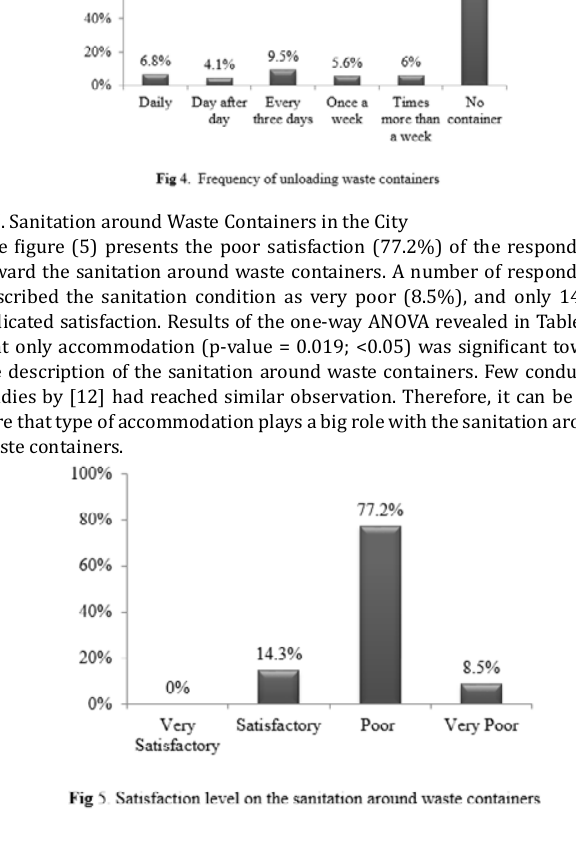
3.4. Residents’ Perception and Awareness about SWM The respondents were also asked regarding the sufficiency of public awareness on proper waste disposal shows in Table (6). Using a five- point scale, ranging from 1 (strongly disagree) to 5 (strongly